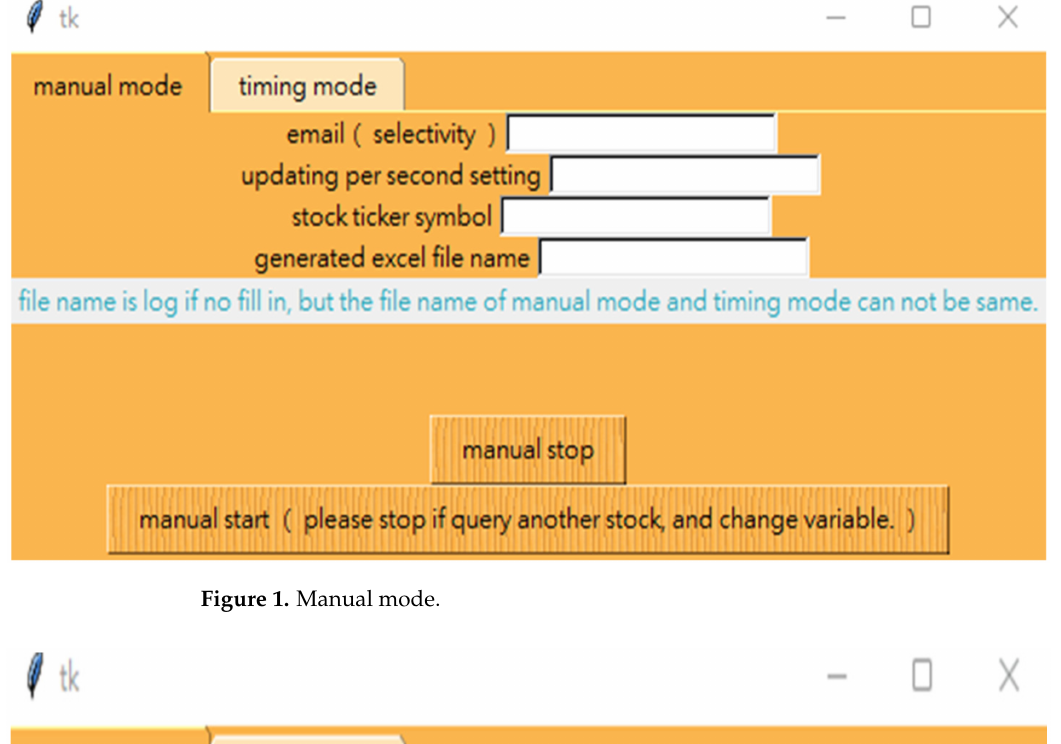
Figure 1. Manual mode.